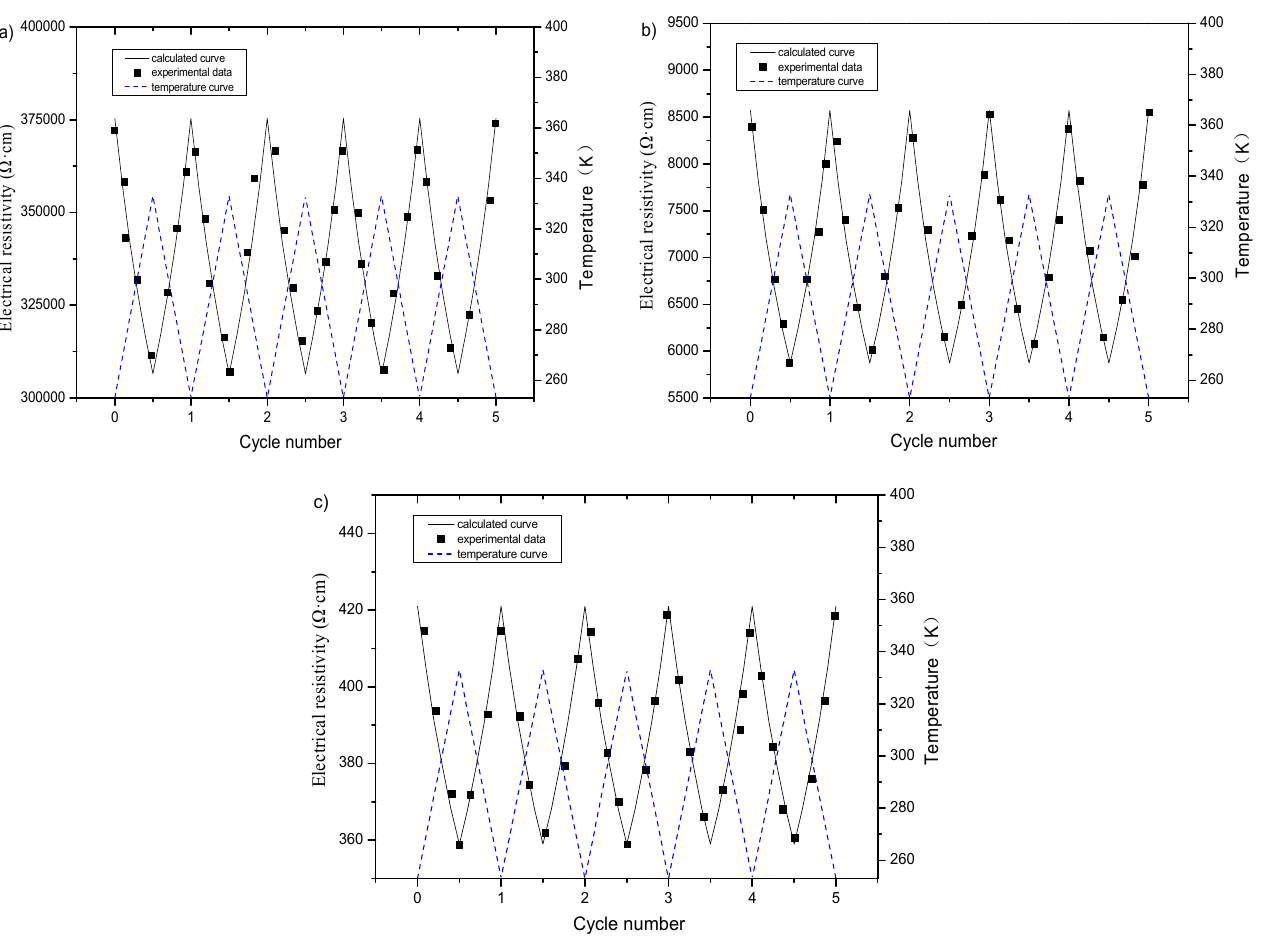
Figure 16. Calculated and measured value of electrical resistivity of specimens with different graphene contents subjected to multiple temperature rise and fall after freeze–thaw: ( a ) 1%; ( b ) 2%; ( c ) 3%. Table 10. Temperature sensitivity of electrical resistivity of specimens incorporating different graphene contents subjected to multiple temperature rise and fall before and after